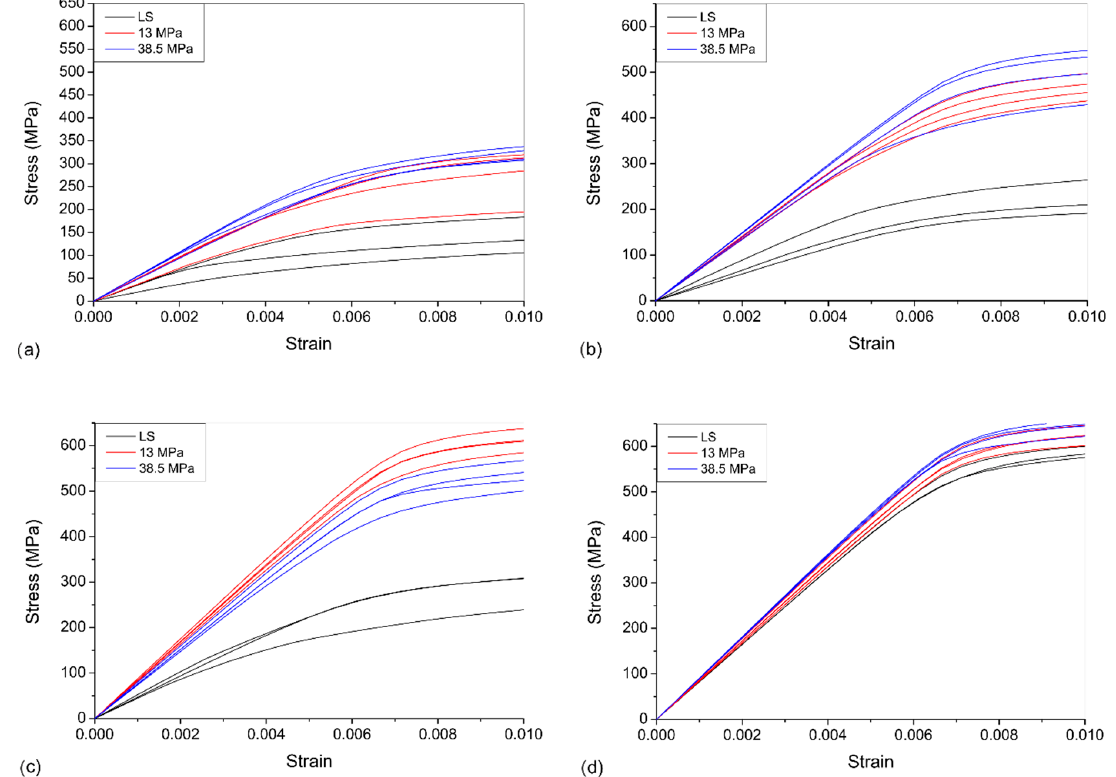
Figure 5. Macroscopic stress–strain response of porous titanium by FE model, for each sintering temperature: ( a ) 1000 °C; ( b ) 1100 °C; ( c ) 1200 °C; and ( d ) 1300 °C. Table 3. Estimated values for elastic modulus and 0.2% o ff set yield strength by FE